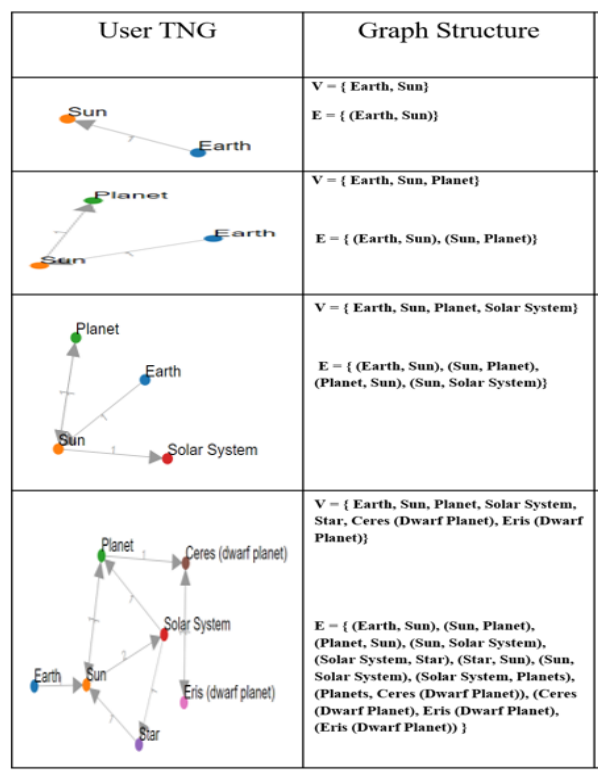
Fig. 2. Illustration of session tracking and TNG building